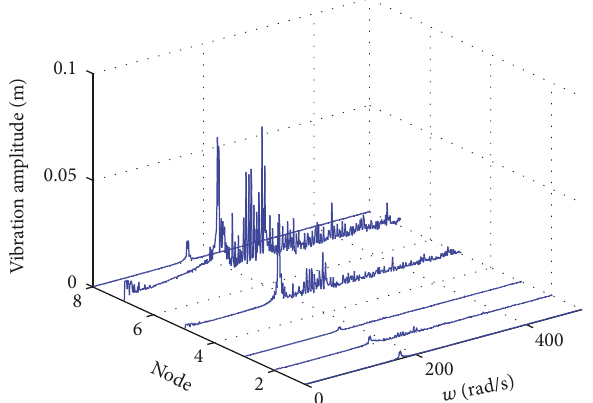
Figure 8: Nodes 7 and 8 vibrations